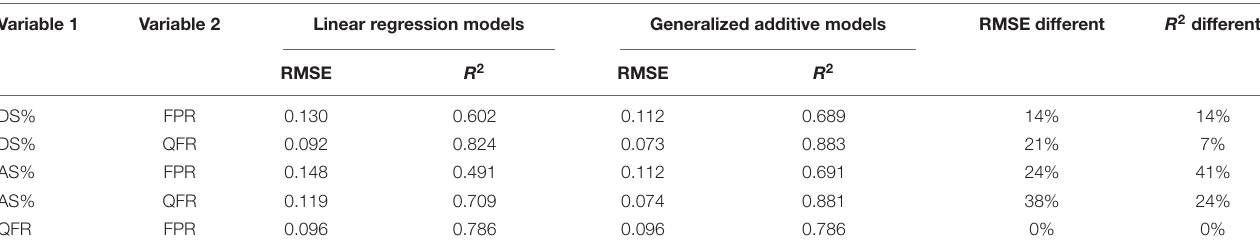
TABLE 2 | Statistical results of goodness-of-fit test for different regression